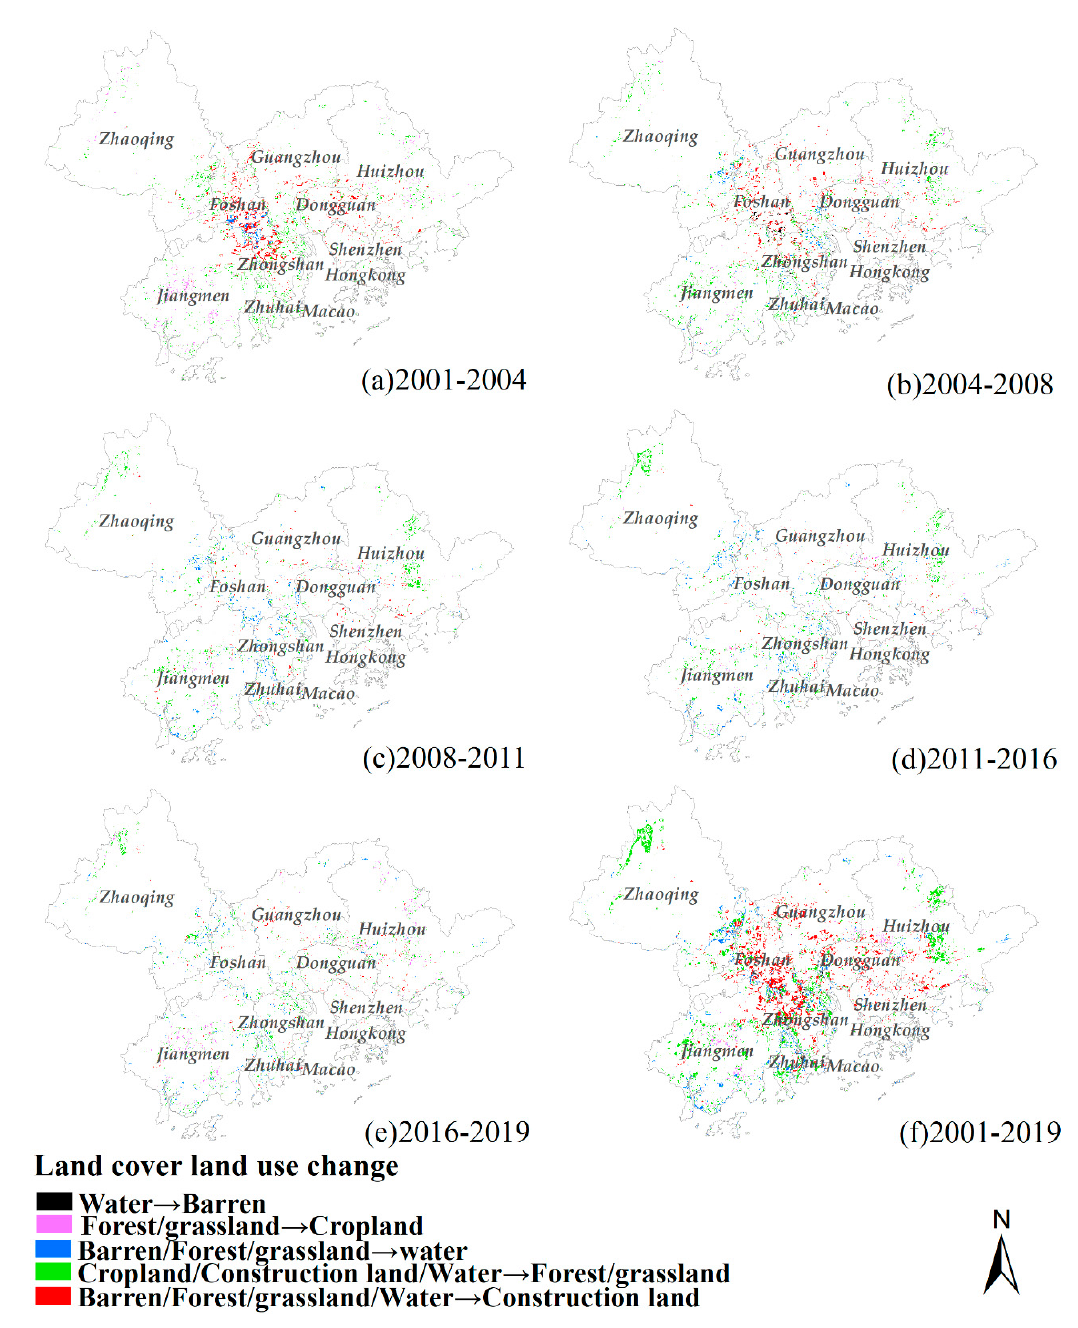
Figure 5. The spatial distribution of land cover land use changed in the GBA from 2001 to 2019.